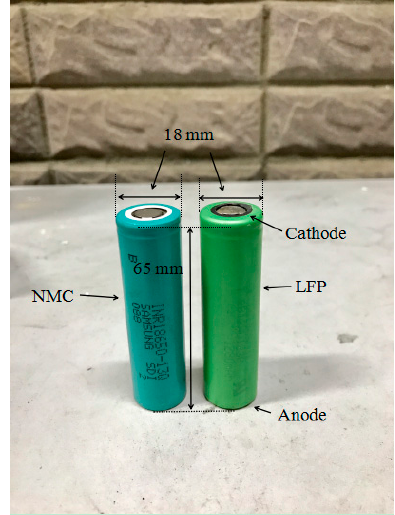
Figure 1. The physical diagrams of batteries.